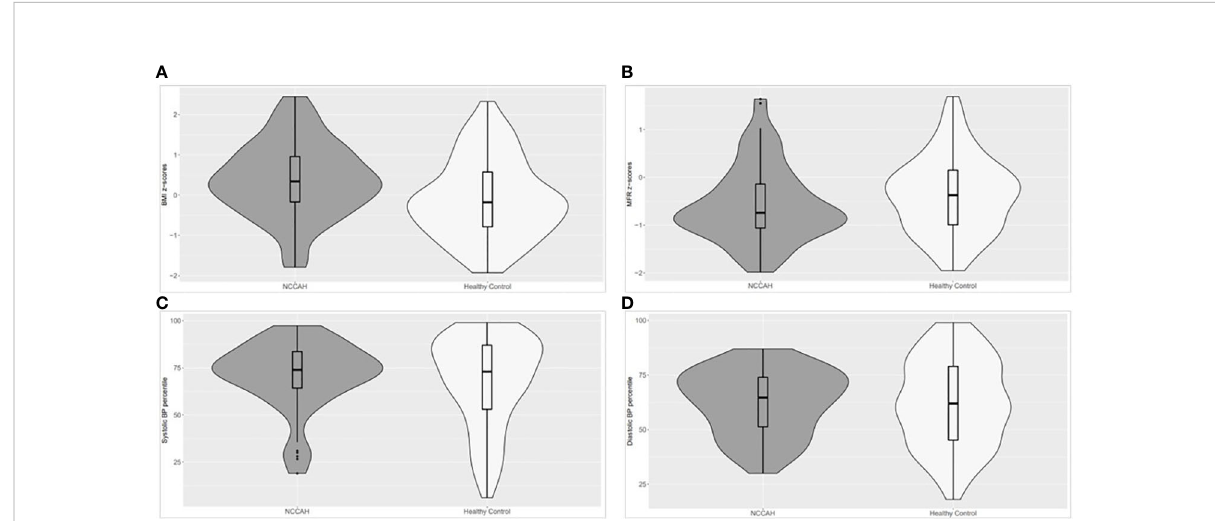
FIGURE 2 Violin plot (distributions of numeric data using probability density curves) depicting the distribution of the median of average BMI z-scores, MFR z-scores, and BP percentiles (systolic and diastolic) in the NCCAH study group and their healthy controls. NCCAH patients are presented in dark grey and healthy controls in white. The violin includes a box plot and summarizes fi ve values: the minimum, fi rst quartile, median, third quartile, and maximum, enabling simultaneous visualization of multiple distributions for comparison. The width describes how frequently that value occurs in the data set: wider regions of the density plot indicate that the value occurs more frequently, and narrower regions indicate that the value occurs less frequently. (A) The NCCAH study group had signi fi cantly higher BMI z-scores than their healthy controls (median [IQR]: 0.34 [-0.17, 0,96] and -0.18 [-0.79, 0.58], respectively, p = 0.001). (B) The NCCAH group had signi fi cantly lower MFR z-scores than their healthy controls (median [IQR]: -0.74 [-1.06, -0.14] and -0.37 [-0.99, 0.15], respectively, p = 0.045). (C) The NCCAH study group had similar systolic BP percentiles as their healthy controls (median [IQR]: 74 [64.3, 83.7] and 73 [53.0, 87.0], respectively, NS). (D) The NCCAH group had similar diastolic BP percentiles as their healthy controls (median [IQR]: 64.7 [51.3, 74.0] and 62 [42.3, 79.0], respectively,